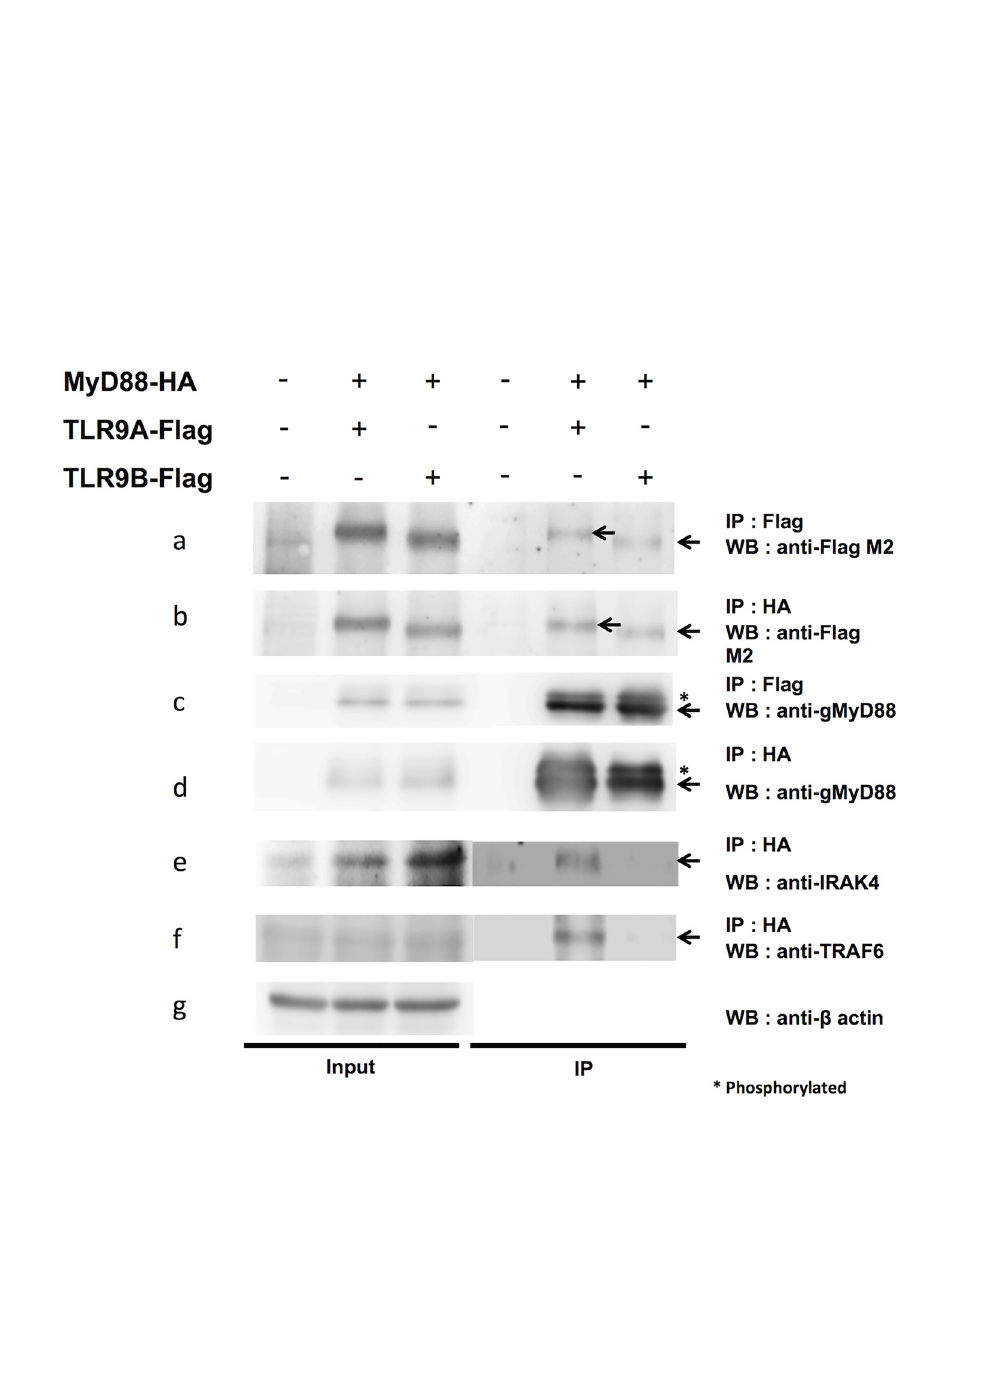
Fig 6. Assembly of gTLR9 signaling complexes. Molecular interactions between gMyD88, gTLR9A/9B, and downstream proteins were investigated by co-immunoprecipitation assay. HEK293T cells were co-transfected with gTLR9A/9B-Flag and gMyD88-HA. Immunoprecipitation was performed with cell lysates incubated with Dynabeads Protein G coated with anti-FLAG or anti-HA monoclonal antibodies. Precipitated proteins were detected using antibodies against Flag, HA, anti-IRAK4, and anti-TRAF6 antibodies. Left panel, total input protein; right panel, immunoprecipitated proteins. Antibodies used for immunoprecipitation and western blotting are listed on the